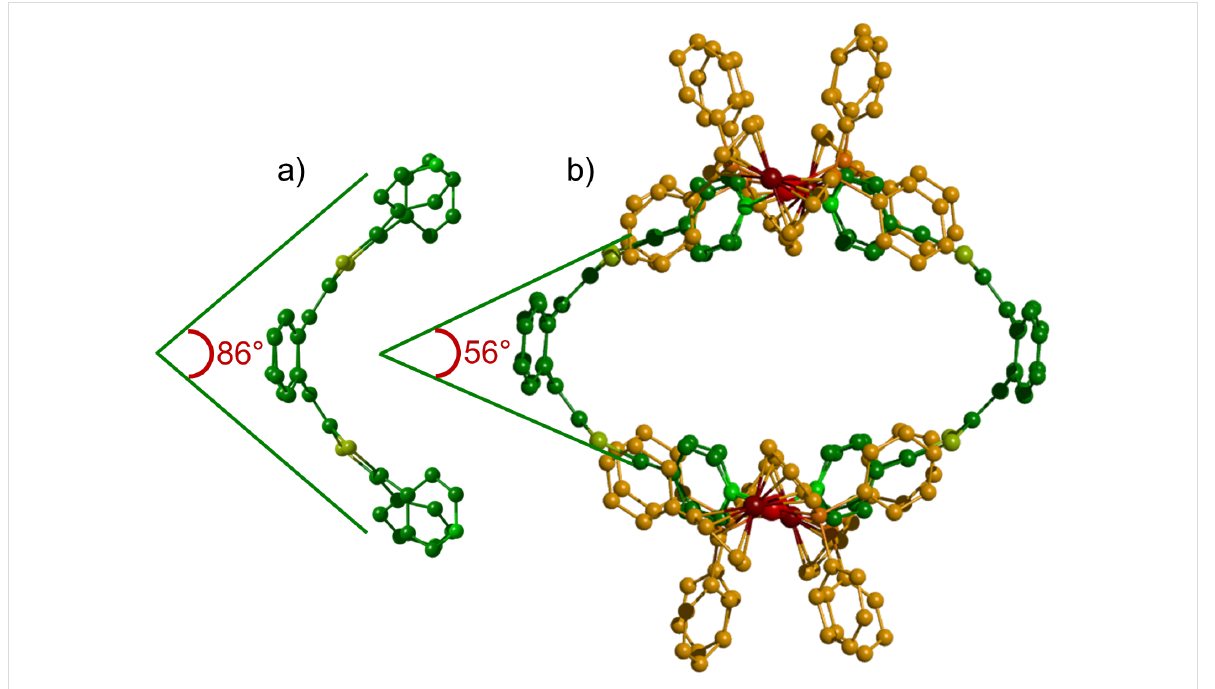
Figure 1: X-ray crystal structures of: (a) ligand L1, (b) self-assembly M 4 L 2 . For clarity, H atoms and TfO − counteranions have been omitted.